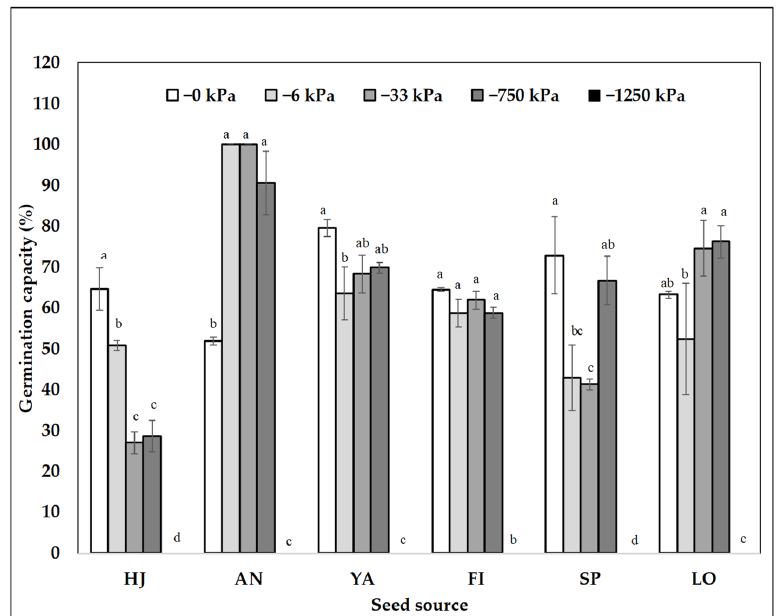
Figure 3. Average of germination capacity of C. alba by seed source and by matric potential (log-kPa). North-south order: HJ = Hijuelas; AN = Antumapu; YA = Coya; FI = Infiernillo; SP = San Pedro and LO = Loncomilla. Lowercase letters show significant difference between matric potential for each seed source according to the non-parametric Kruskal–Wallis test ( p < 0.05).